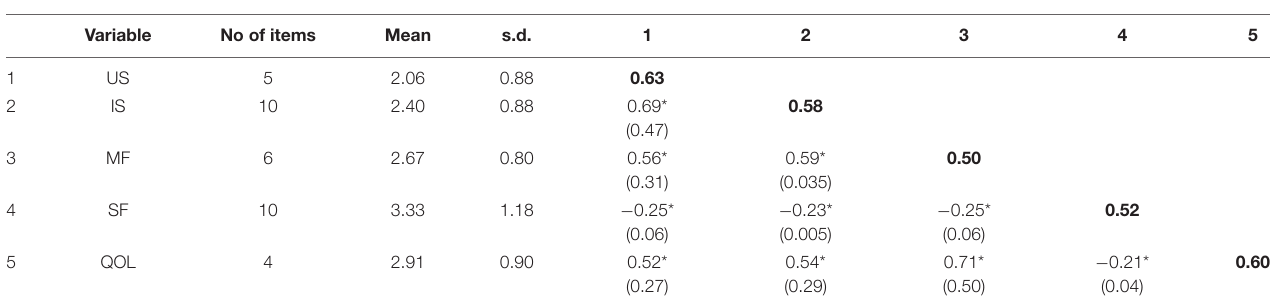
TABLE 3 | Descriptive statistics and correlations.